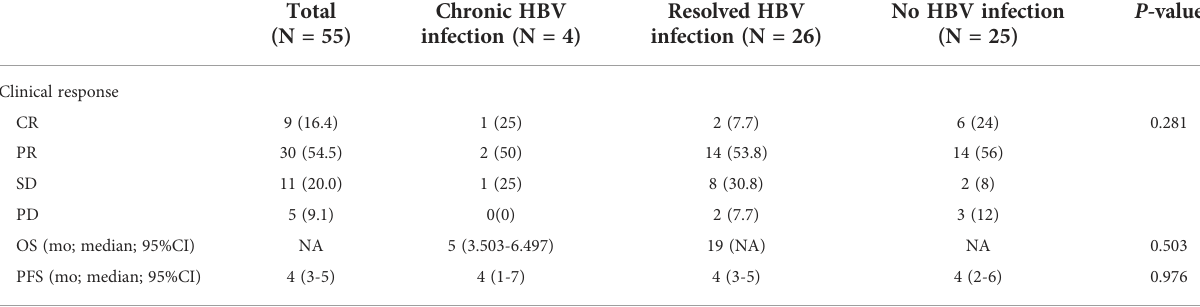
TABLE 4 Clinical response and survival of R/R DLBCL patients treated with BTKis (N =